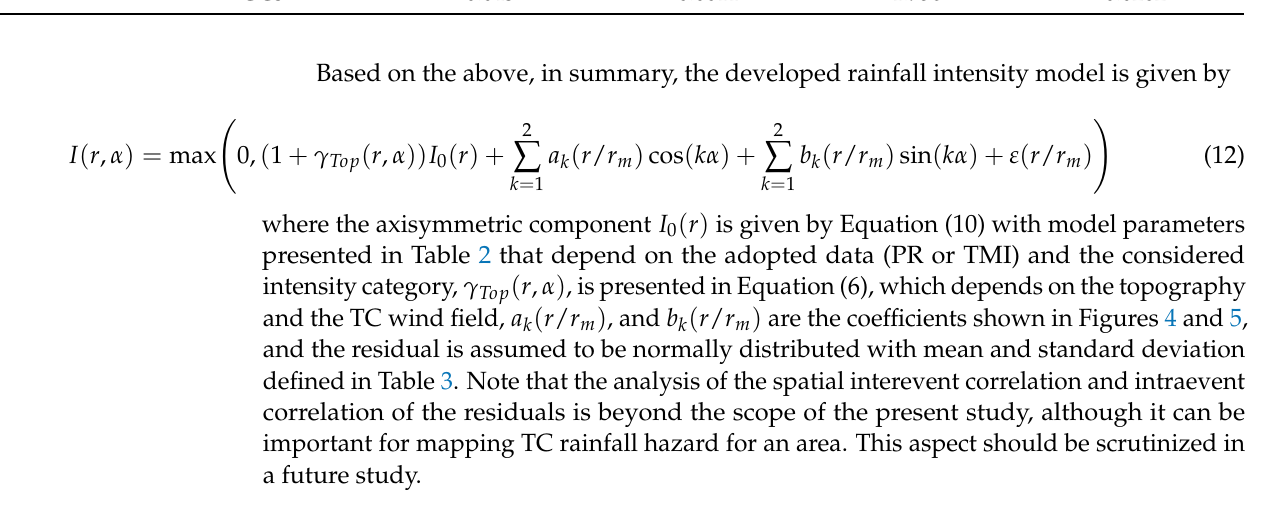
u . The minimum c